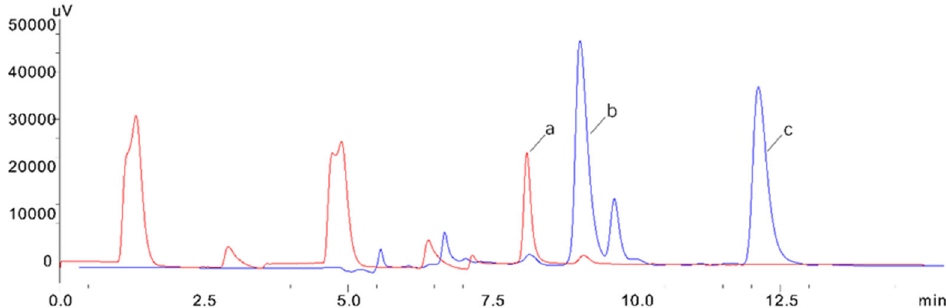
Figure 1. Comparison between the PRS cation exchange column (blue) and HLB solid phase extraction column (red). ( a ) Gelsemine, ( b ) koumine and ( c ) humantenmine.